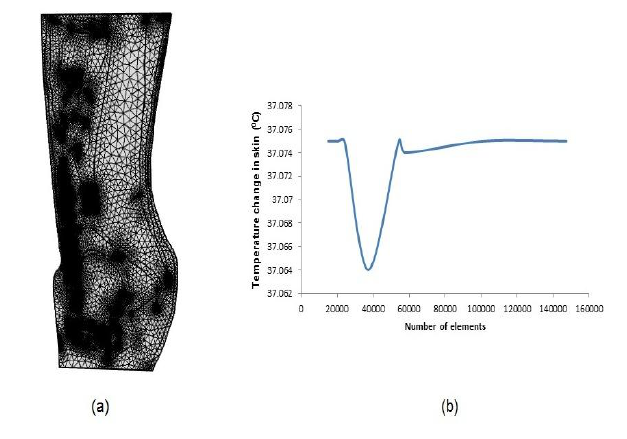
Figure 3: (a) Tetrahedral mesh and (b) mesh convergence for FEM